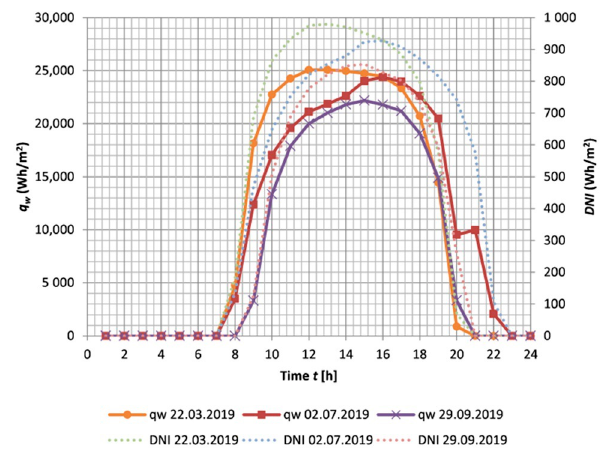
Figure 6. Calculated heat flux density per one square meter of an absorber and DNI for selected days for the Solar Thermal Power Station in Spain.